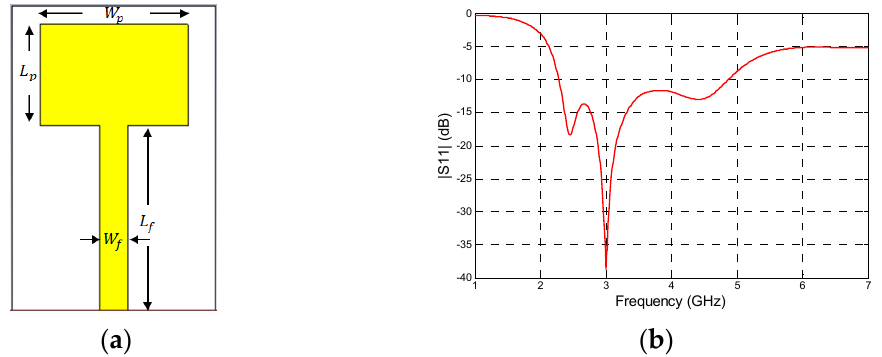
Figure 1. The proposed antenna structure.